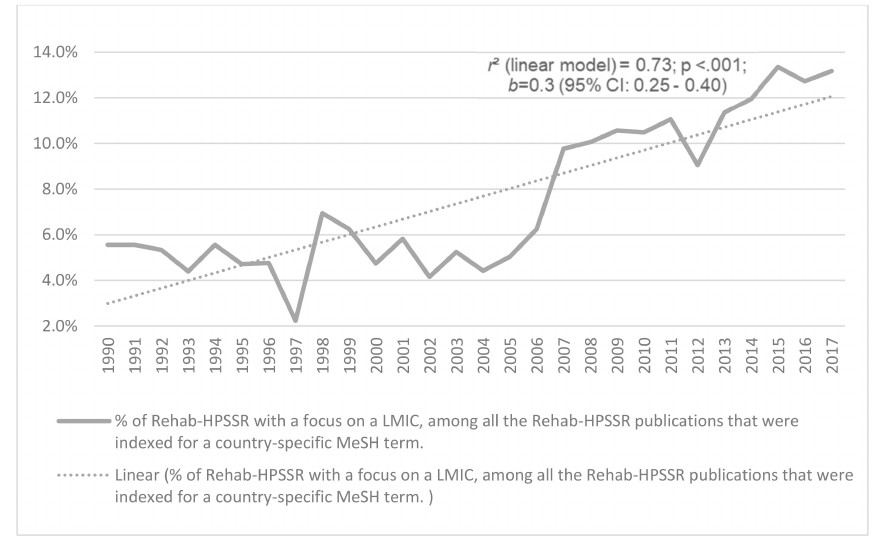
Figure 4. The yearly percentage of the rehab (i.e., rehabilitation) Health Policy, Systems and Service Research (HPSSR) focused on Low- and Middle-Income Income Countries (LMICs) among all rehab-HPSSR publications with a country-specific Medical Subject Heading [1990–2017], and the regression model (i.e. the linear) that had the best fit with the data. The p value and 95% Confidence Interval (CI) refer to the linear regression